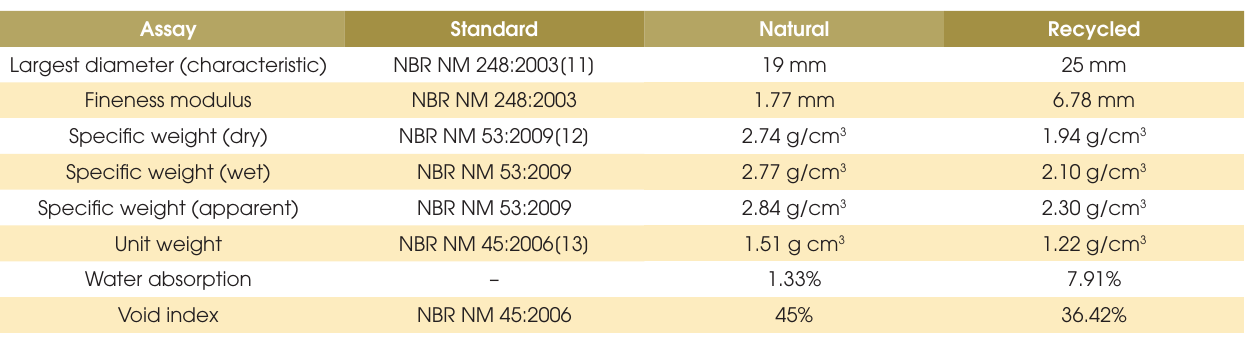
Table 1 – Characterization of natural and RCA